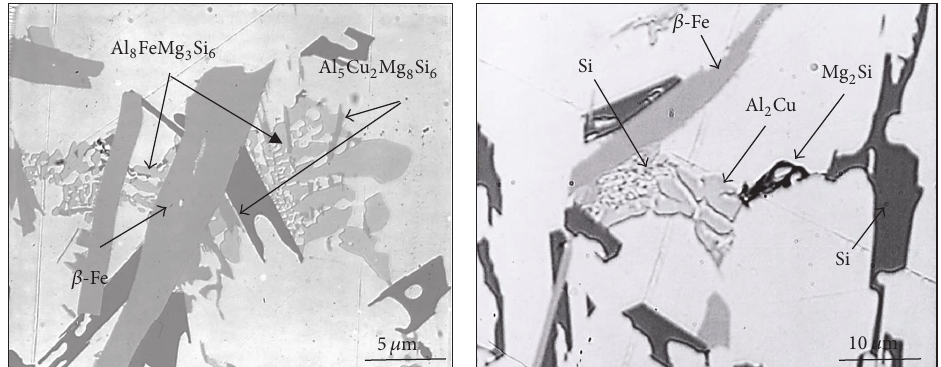
Figure 3: Microstructure of the as-cast DCM5 alloy (thermal analysis) showing different phases. The average dendrite arm spacing is 85 𝜇 m.